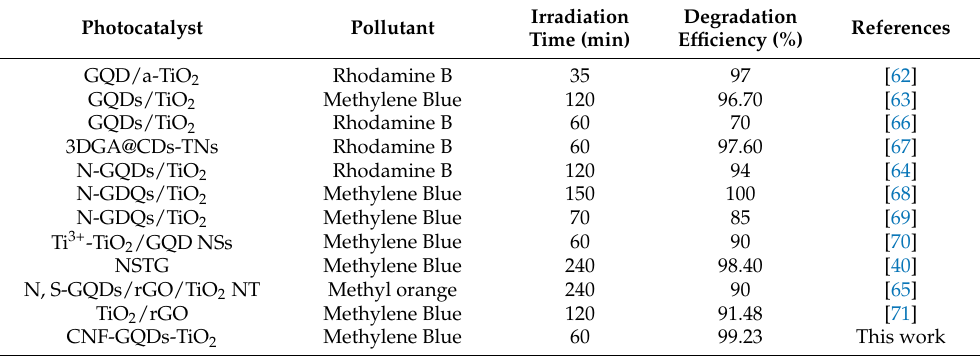
Table 2. Comparative data analysis of dye degradation using GQDs based TiO 2